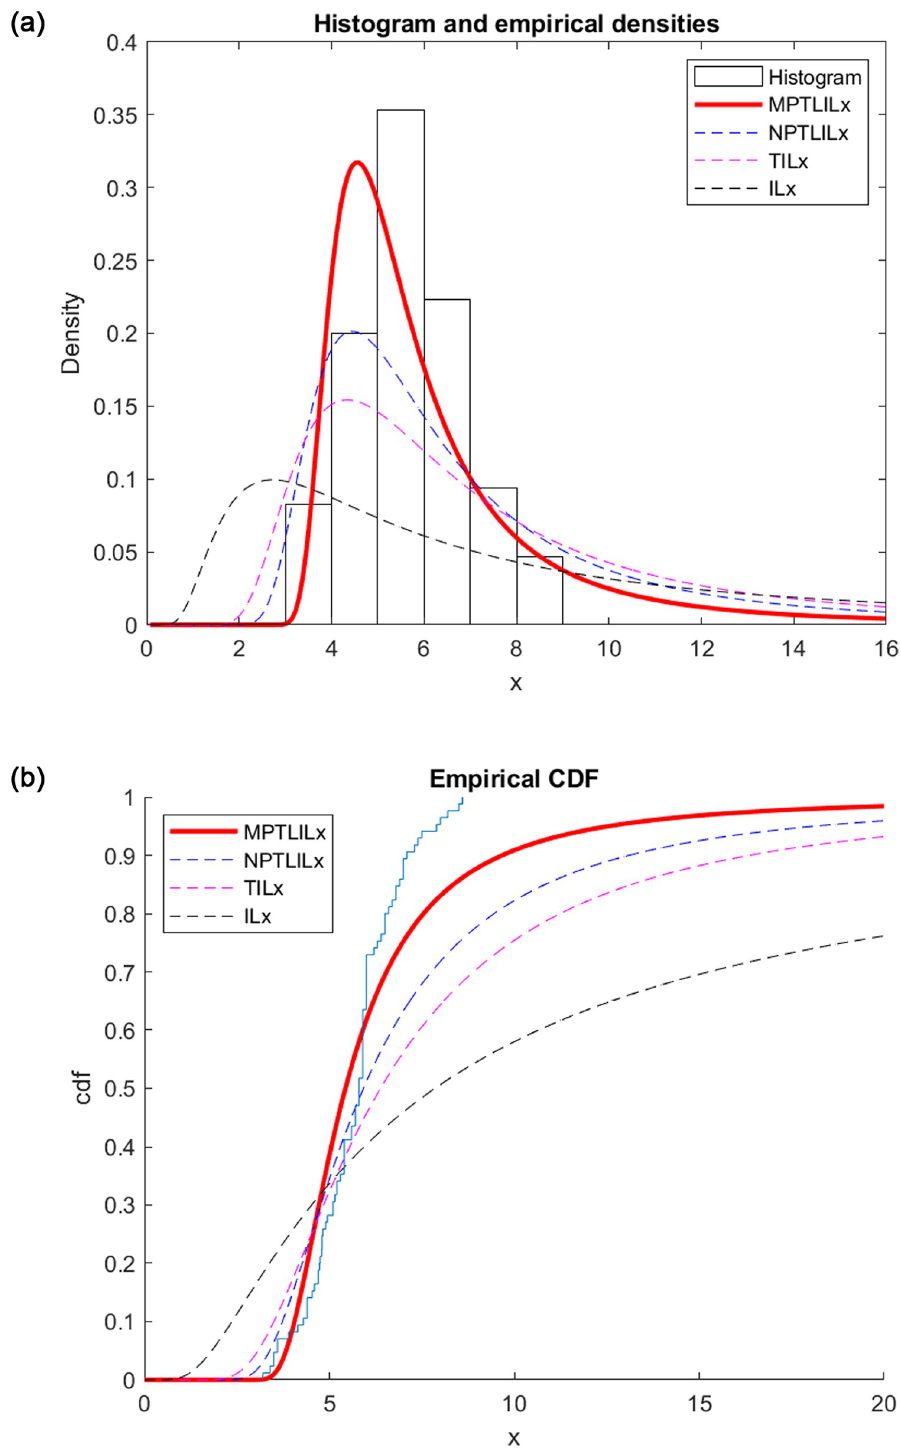
Fig 3. Graphical representation of the empirical pdfs and CDFs (dataset I). (a) pdfs representation. (b) CDFs representation.